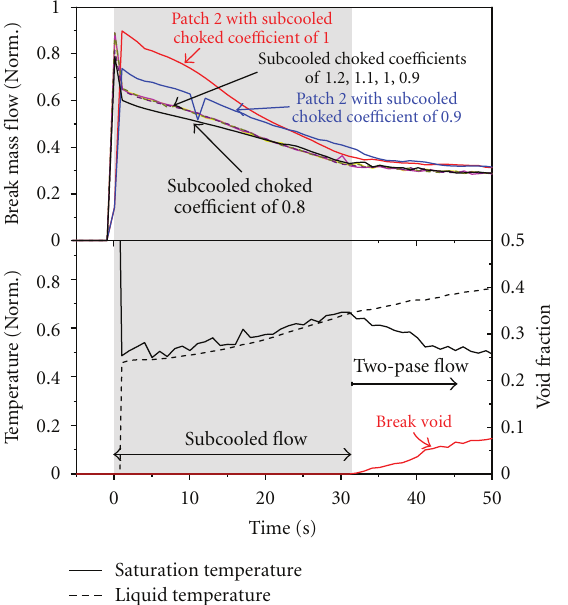
Figure 16: Break mass flow during the subcooled phase for Test 2; di ff erent subcooled choked coe ffi cients are used for the TRACE v5.0 RC3 and patch 2